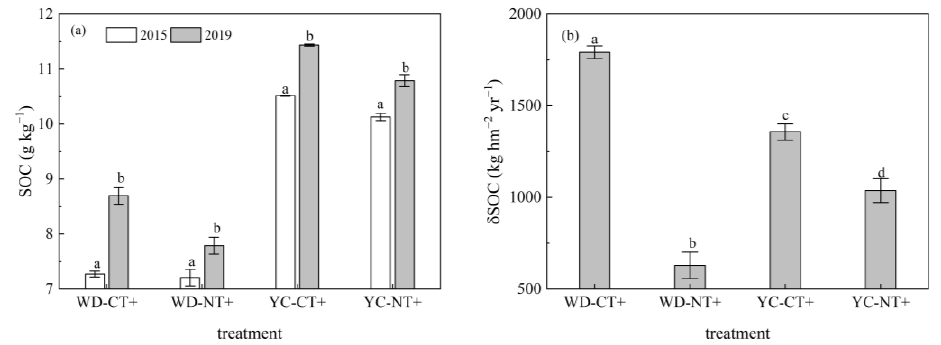
Figure 3. SOC ( a ) and δ SOC ( b ) in the CT+ and NT+ treatments at Wudi (WD) and Yucheng (YC) sites CT+ is crop residue incorporated into the soil with plough tillage, NT+ is crop residue mulching with no-till. The small letters indicate the significant differences across treatments at p < 0.05